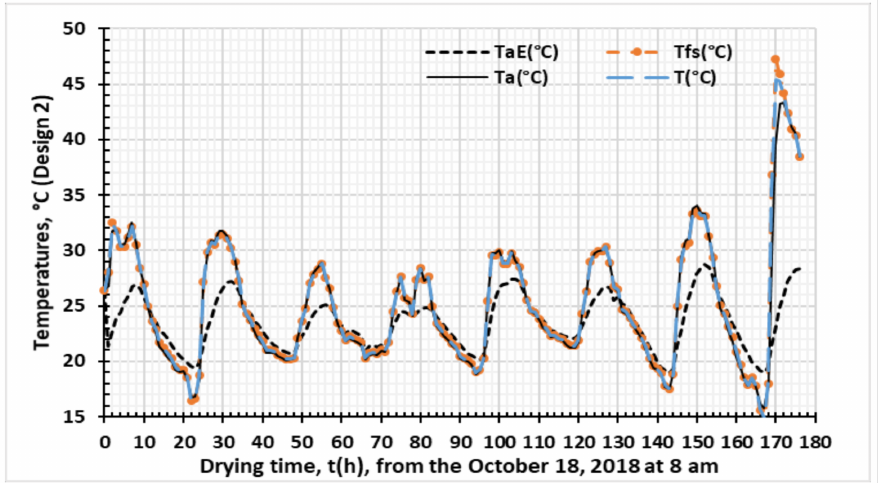
Figure 7. Evolutions of temperatures of ambient air (TaE), drying air (Ta), of the product (T) and airflow air outlet the solar collector (Tfs) in Yamoussoukro, October 2018, design